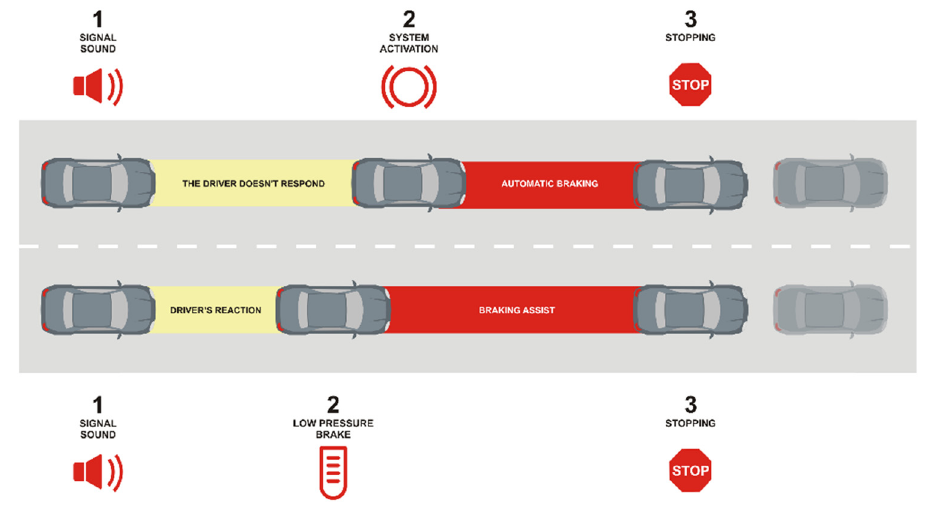
Figure 4: The principle of operation of the emergency braking system. Source: “ authors ” own study based on ref. [ 13 ]